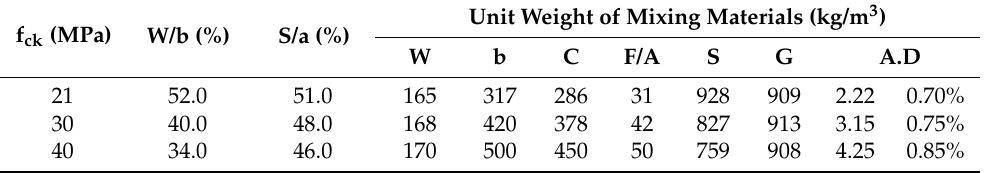
Table 7. Concrete specific mixing table.